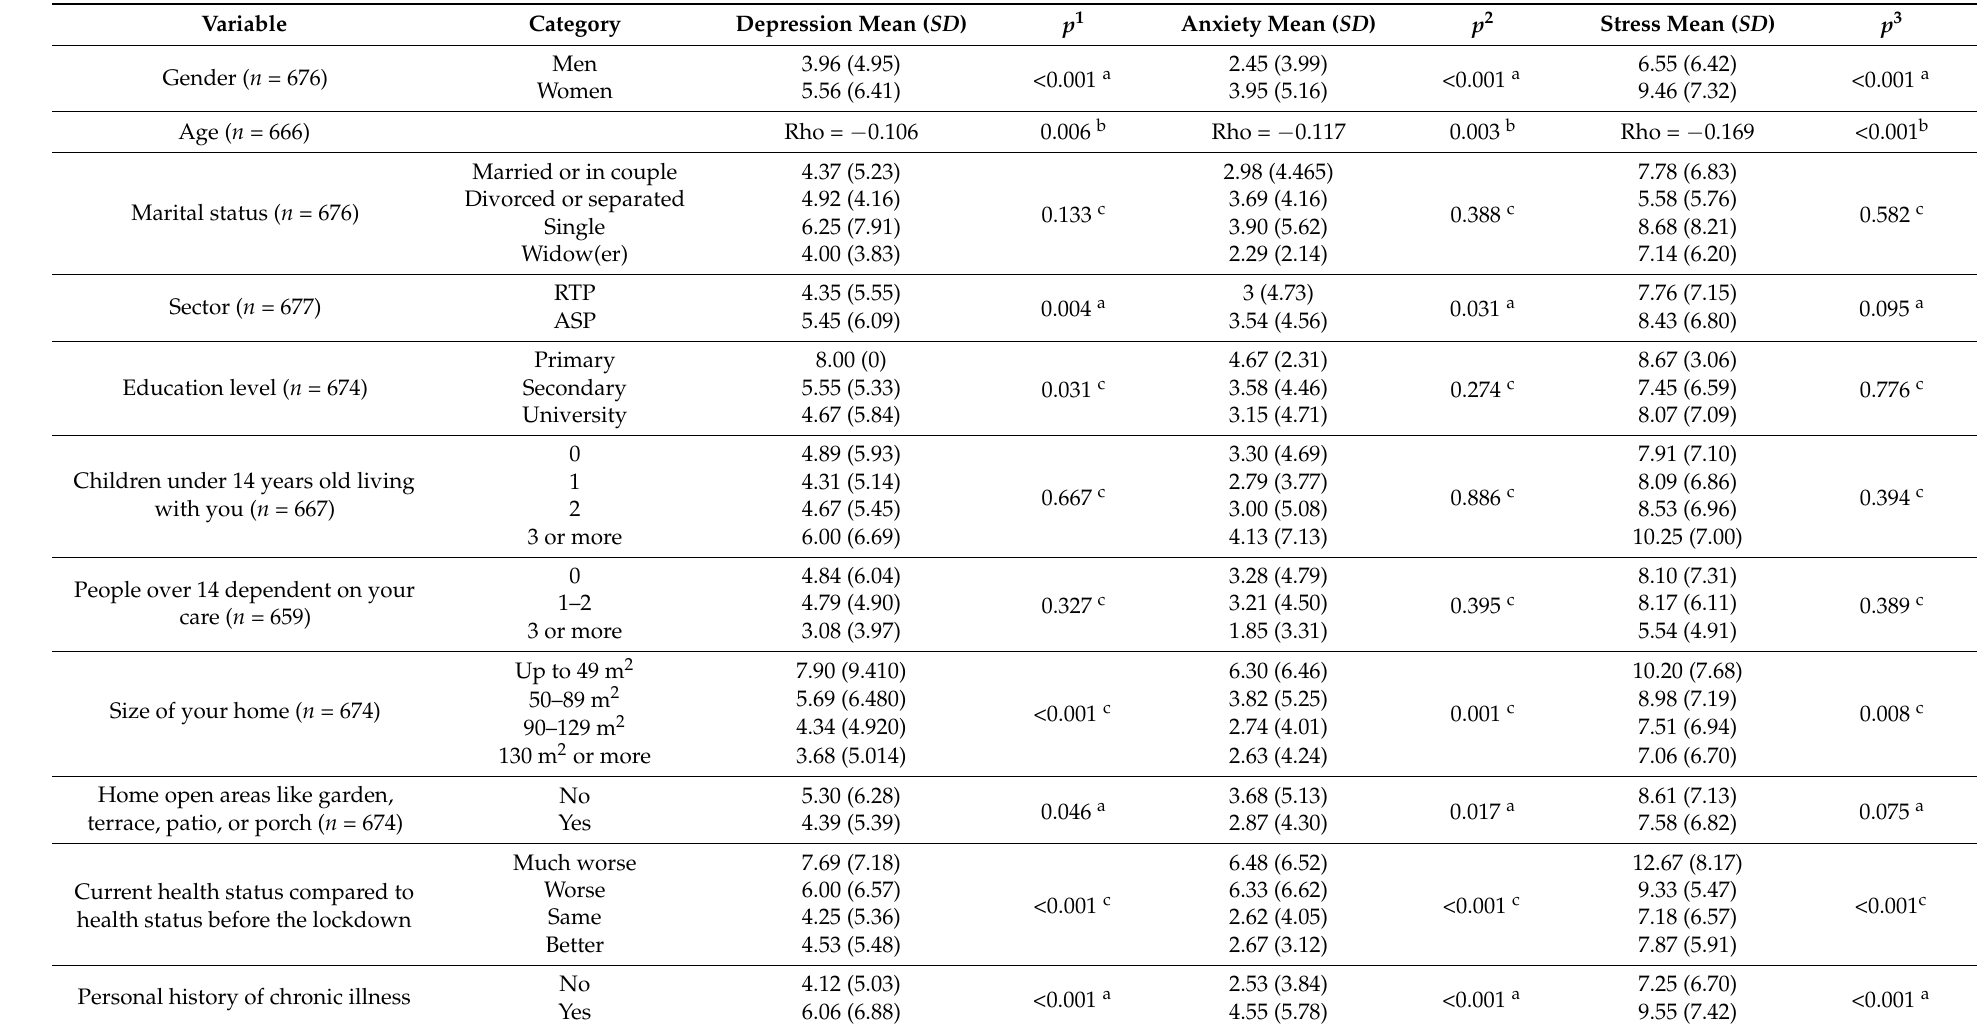
Table 2. Factors related to the scores for depression, anxiety, and stress: bivariate